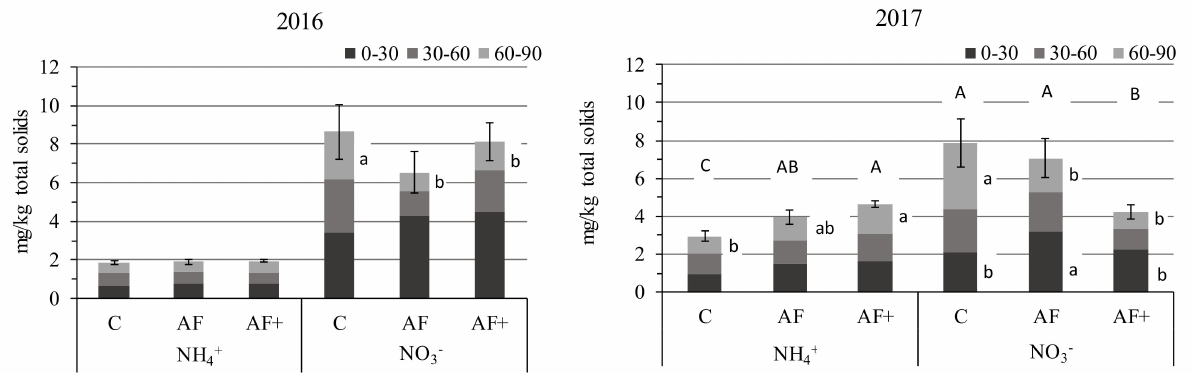
Figure 5. NH 4+ and NO 3 − concentration (mg Kg − 1 TS, TS = total solids; mean ± S.E., n = 13) of the soil samples collected in the three treatments (C, AF and AF+) during February both in 2016 ( left ) and 2017 ( right ). Each soil sample was divided into three subsamples according to the depth: 0–30, 30–60 and 60–90 cm. Standard error bars refer to the average NH 4+ and NO 3 − concentration of the entire samples (0–90 cm depth). For each year and each ion, different capital letters indicate significant difference between treatments considering the 0–90 cm soil profile; small letters indicate significant difference between treatments within each of the three-soil subsample (0–30, 30–60 and 60–90 cm), according to Tukey’s HSD test ( p ≤